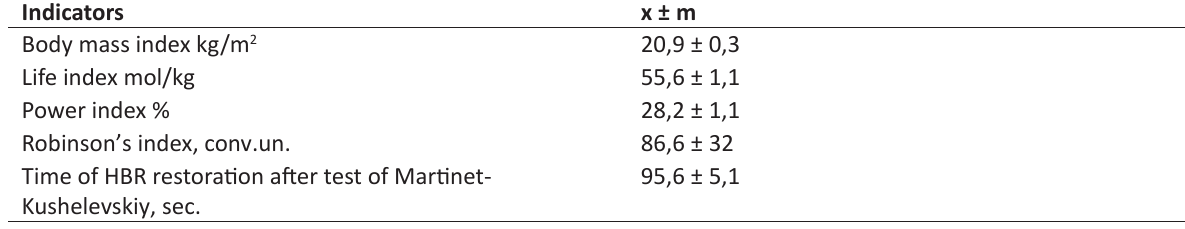
Table 2. Indicators of 1 st – 2 nd year girl students’ physical health (KNMU)